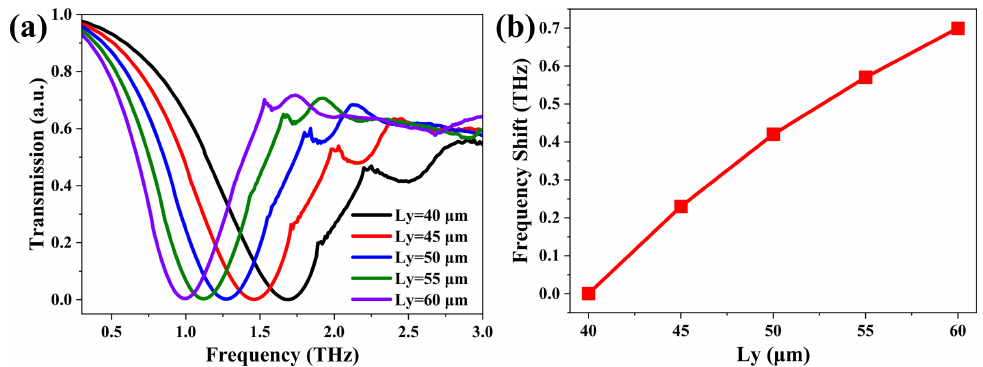
Figure 2. ( a ) Normalized THz transmission amplitudes of the investigated BTR with different L y . ( b ) The resonance-frequency shift as a function of L y